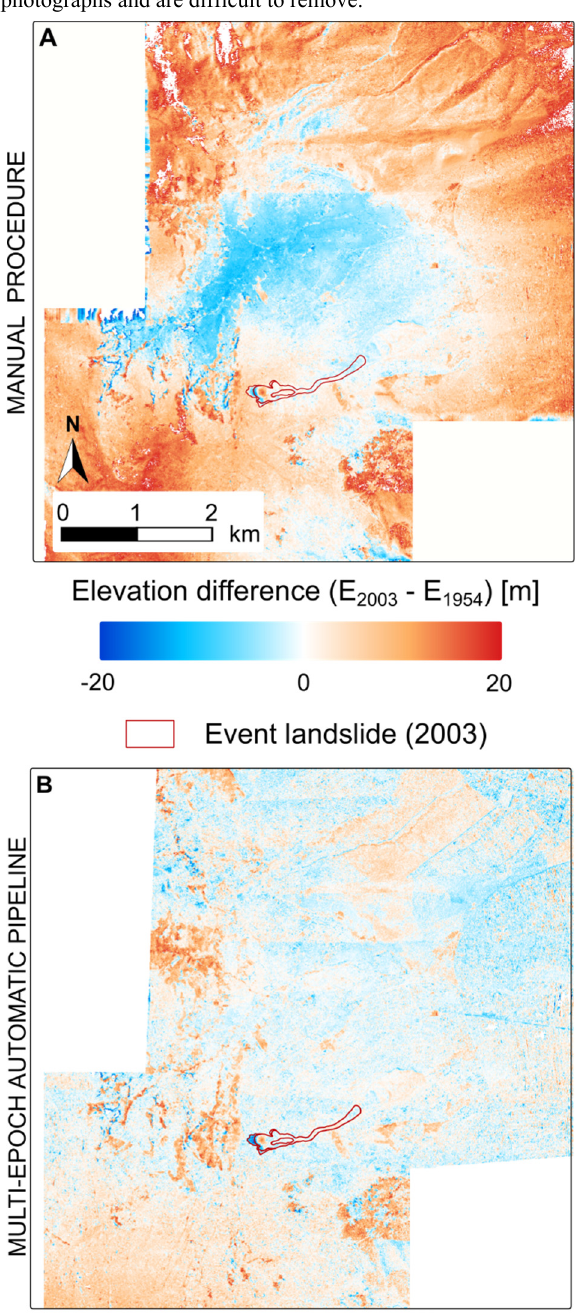
Figure 3. Comparison of DoDs computed using the manual procedure (A) and the automatic procedure (B). Blueish colors indicates areas where land surface has decreased through time as opposed to reddish colors.